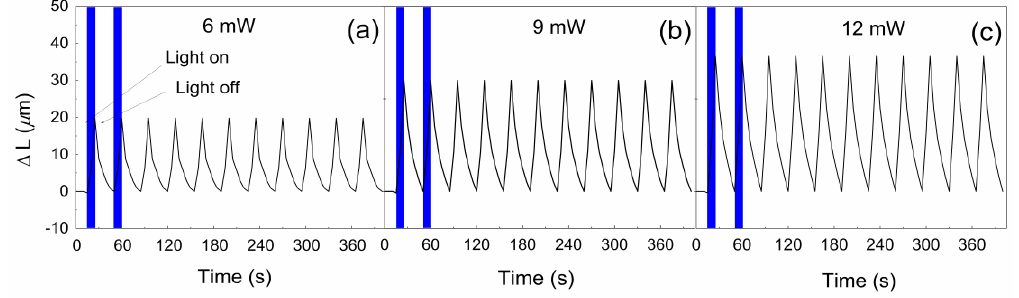
Figure 12. Photo-actuation performance of GO-PGMA 2/PDMS composite at ( a ) 6 mW; ( b ) 9 mW; and ( c ) 12 mW irradiation intensity.